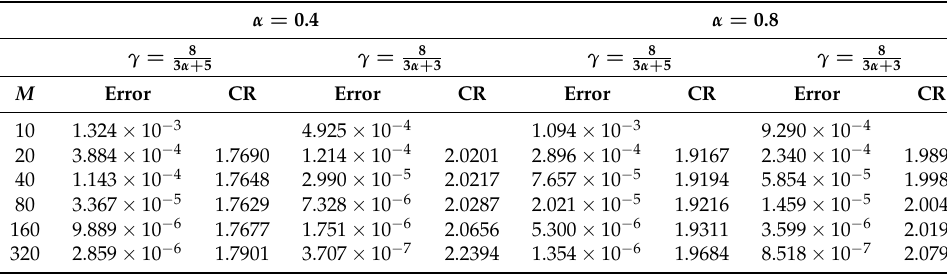
Figure 2. Log -log error plots for Example 1 with g ( u ) = u 2 , showing the rate of convergence of the scheme. Table 1. g ( u ) = 0 with β = 1.2.